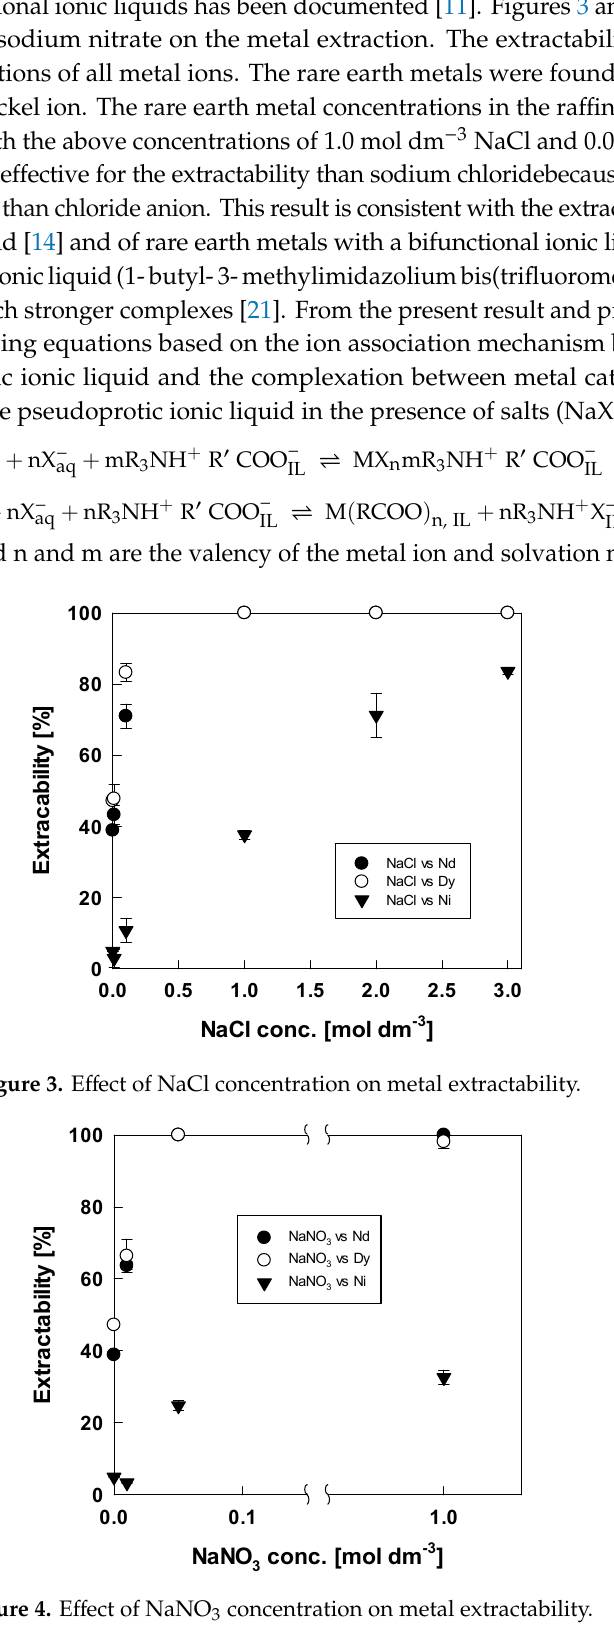
Figure 4. E ff ect of NaNO 3 concentration on metal Figure 4. Effect of NaNO 3 concentration on metal extractability.